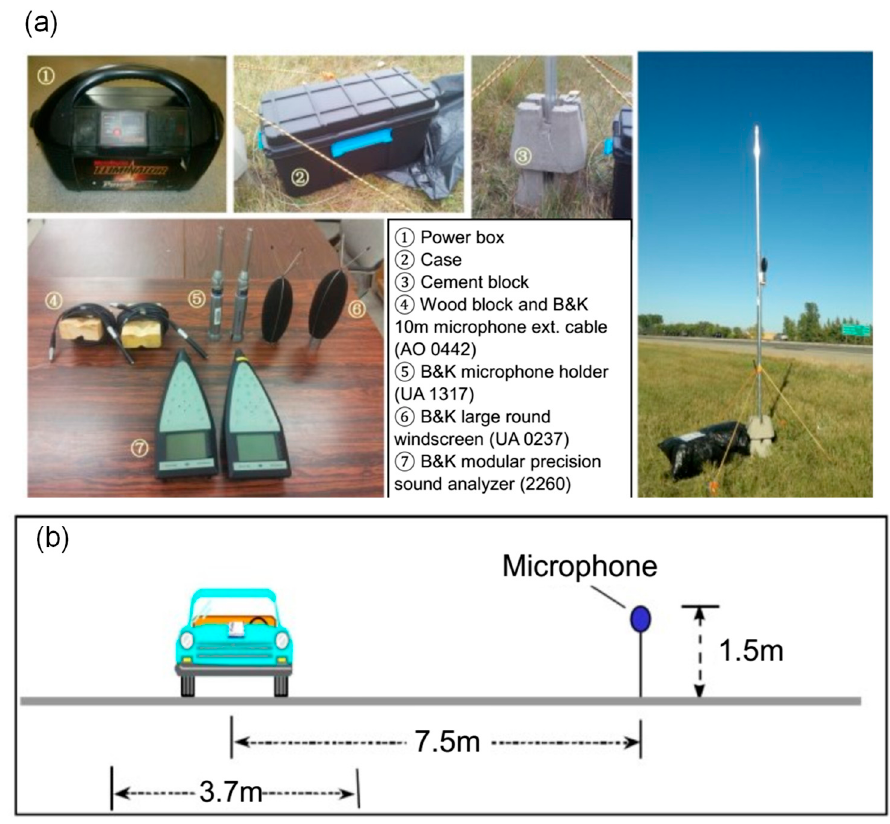
Figure 3. Traffic noise measurement instrument ( a ) and installation ( b ). Figure 3. Tra ffi c noise measurement instrument ( a ) and installation ( b